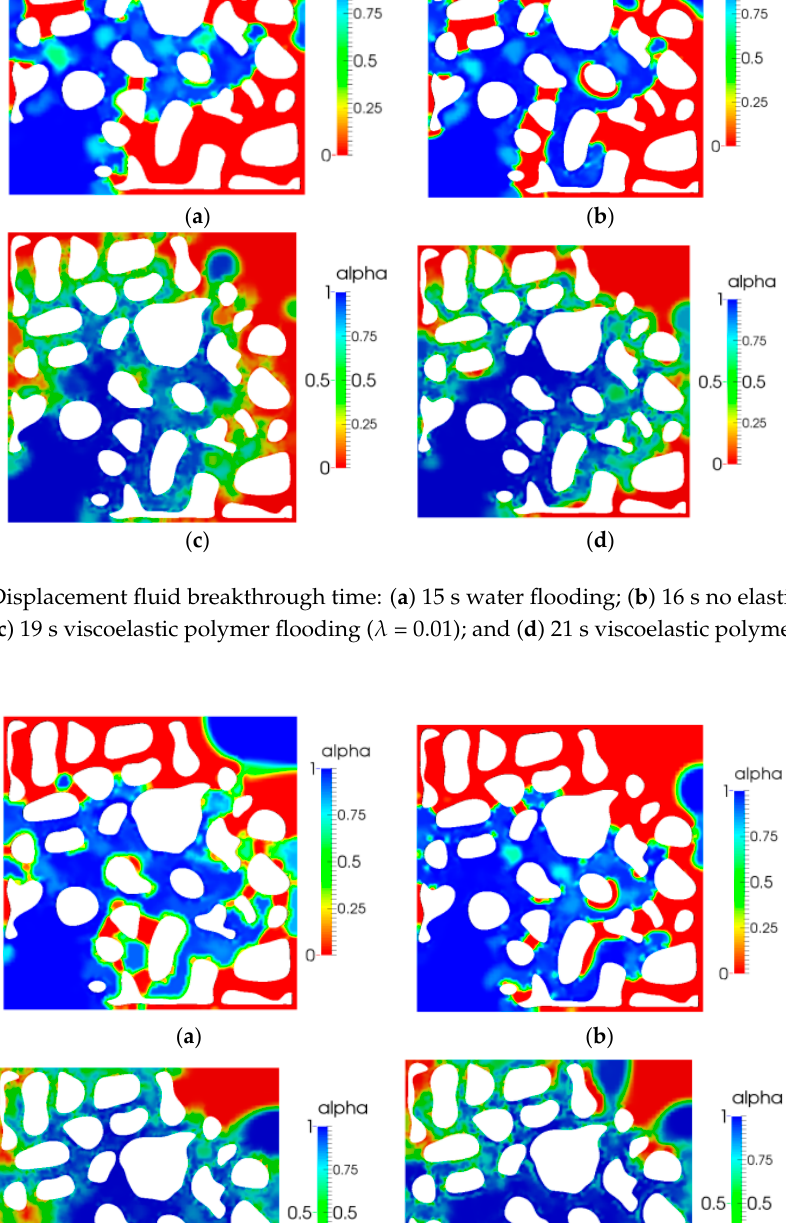
Figure 8. Saturation distribution after breakthrough ( t = 28 s): ( a ) water flooding; ( b ) no elastic polymer flooding; ( c ) viscoelastic polymer flooding ( λ = 0.01); and ( d ) viscoelastic polymer flooding ( λ = 0.03).